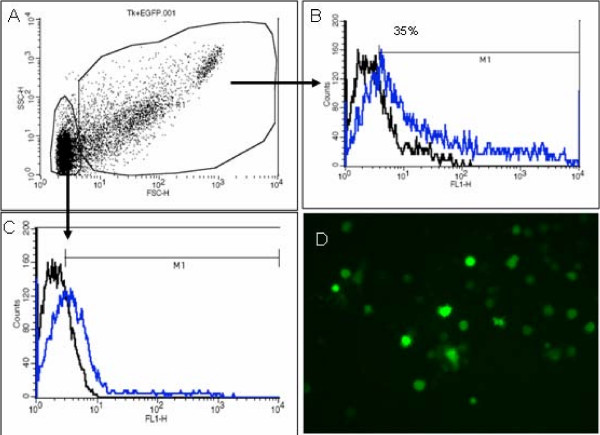
Transfection efficiency using adenoviral vectors containing EGFP as a reporter gene. Flowcytometric analysis shows 30% to 35% EGFP positive cells in both cell populations. Fluorescent microscopy also shows EGFP positive cells in culture even after 12 days of infection.